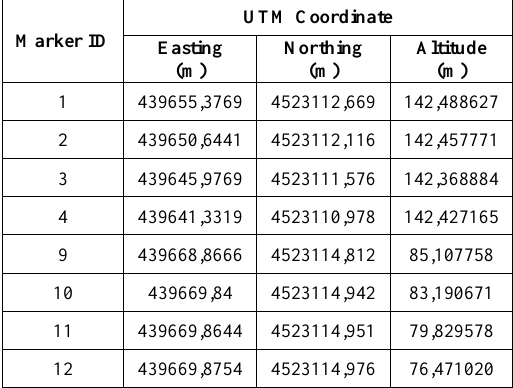
Table 2. Points’ World